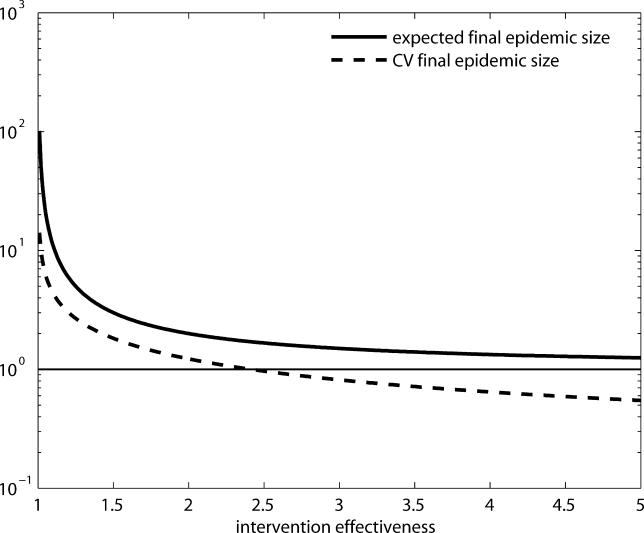
Expected Final Outbreak Size and CV in the Final Outbreak Size as a Function of Intervention EffectivenessThe expected final outbreak size (solid line) and CV in the final outbreak size (dashed line) are shown as a function of intervention effectiveness (the ratio of the removal rate and contact rate γ/β) for the simple stochastic epidemic. The light horizontal line designates the benchmark where CV = 1.